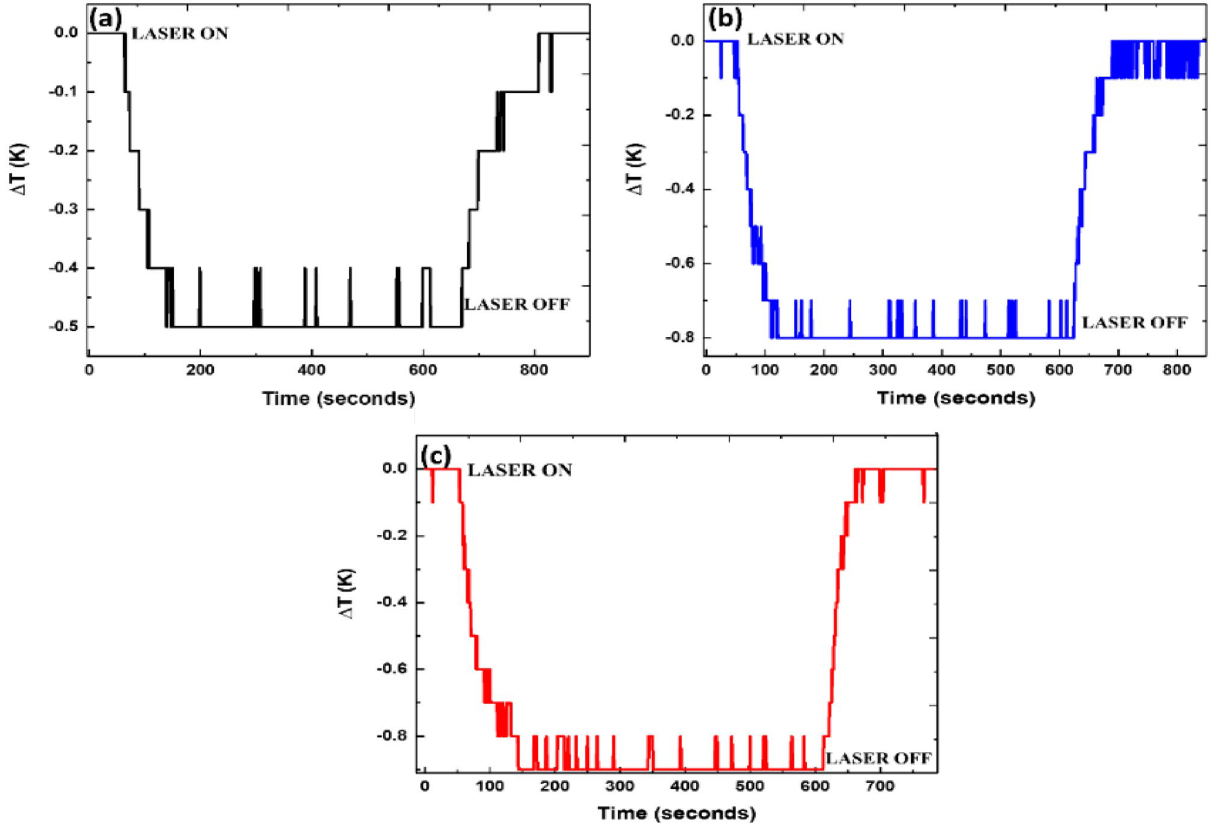
Figure 3. The temperature dynamics of ( a ) GAYY-1, ( b ) GAYY-2, and ( c ) GAYY-3 and while pumping with 6.5 W 1029 nm